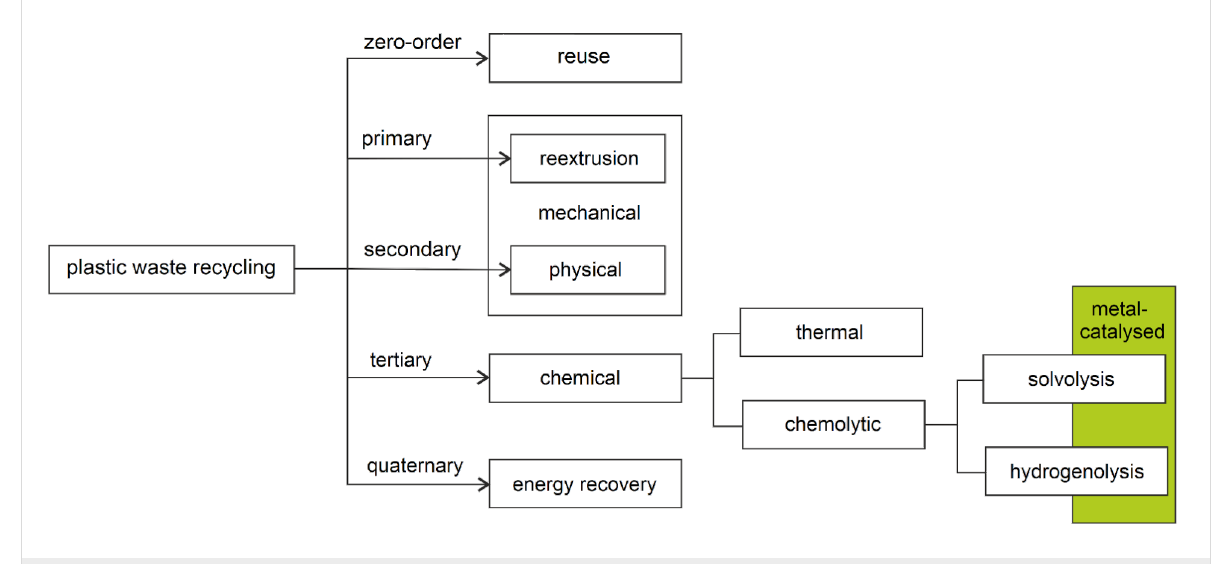
Figure 1: Potential classification of plastic recycling processes. The area covered by the present review is highlighted in green.